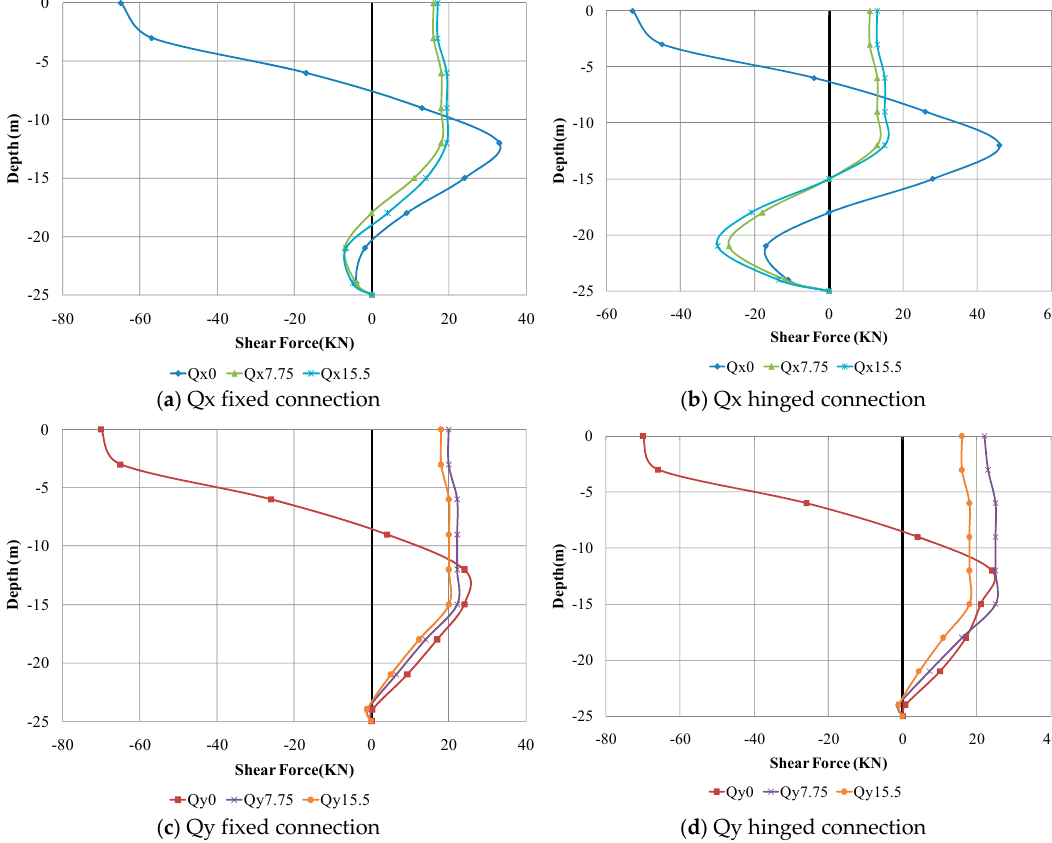
Figure 9. Shear forces acting on the selected piles P1, P2, and P3 assuming fixed and hinged pile-platform connections.